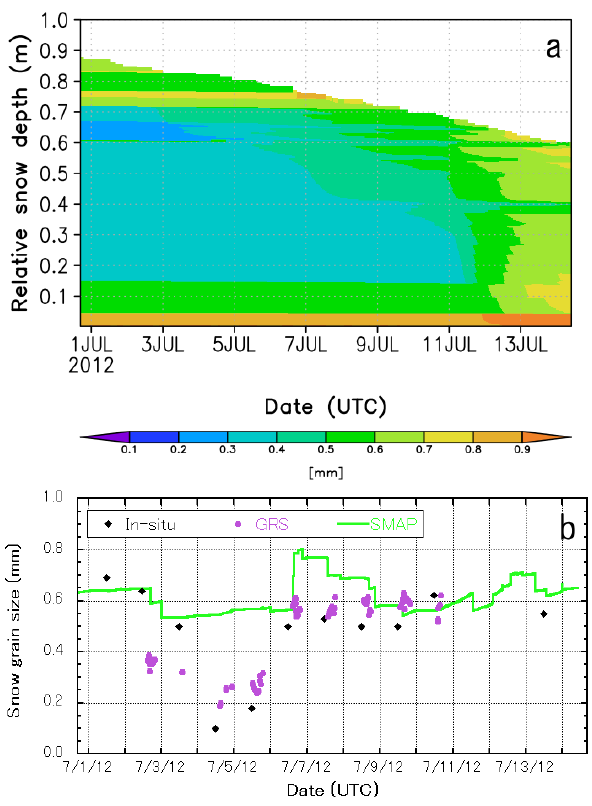
Figure 8. Temporal evolution of (a) simulated snow grain size pro- file in the NSL and (b) surface snow grain size from in situ snow pit observations (black diamond patterns), ground-based remote sens- ing (GRS) using spectral albedo data measured with a spectrometer (purple dots), and simulated by the SMAP model (solid green curve) at the SIGMA-A site during the IOP. Vertical axis in the upper panel (relative snow depth) denotes the height above the thick bottom ice layer in the